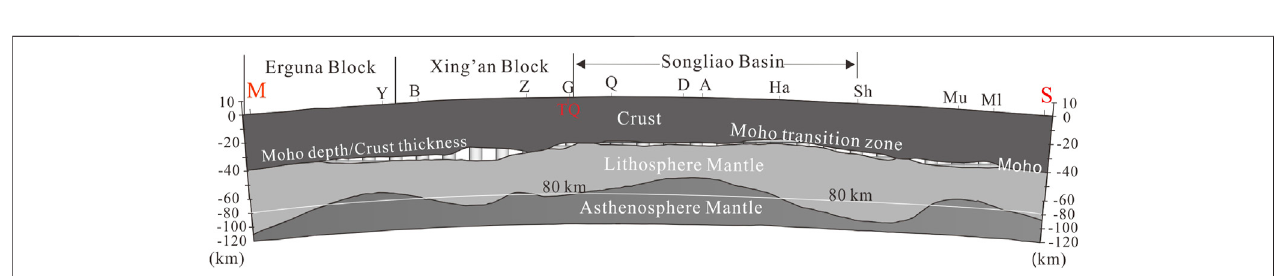
FIGURE 10 | (A) Plot of K/Yb vs. Dy/Yb for lamprophyres in the Tuquan Basin. Melting curves for garnet lherzolite, spinel lherzolite, garnet-facies phlogopite lherzolite, garnet-facies amphibole lherzolite and spinel-facies amphibole lherzolite are taken from Duggen et al. (2005). (B) La/Yb vs. Dy/Yb in lherzolite REE melting model is from Thirlwall et al. (1994), partition coef fi cients are from McKenzie and O ’ Nions (1991).